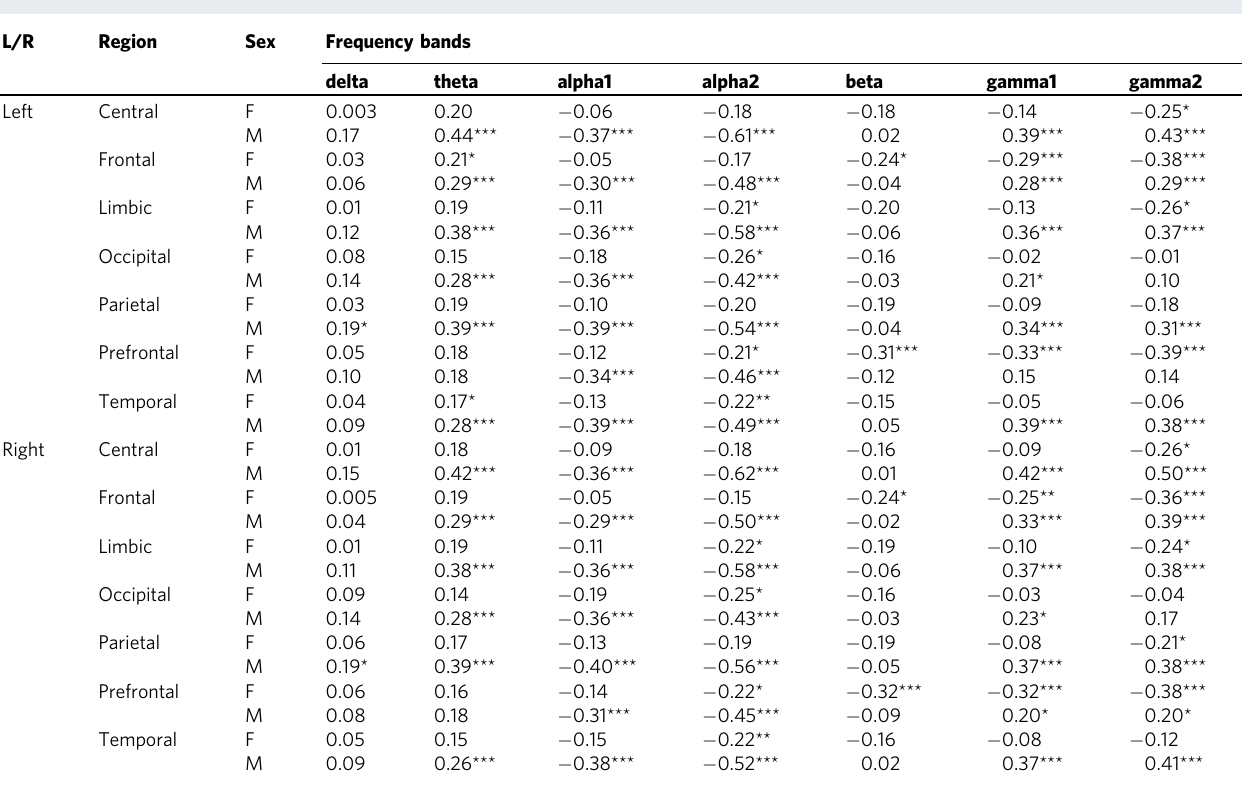
Table 2 Sex and group differences in cortical regions by frequency